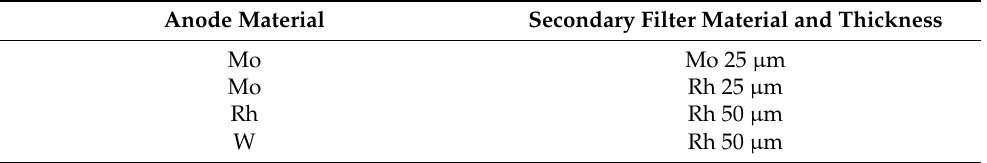
Table 1. Simulated combinations of the anode material and the secondary